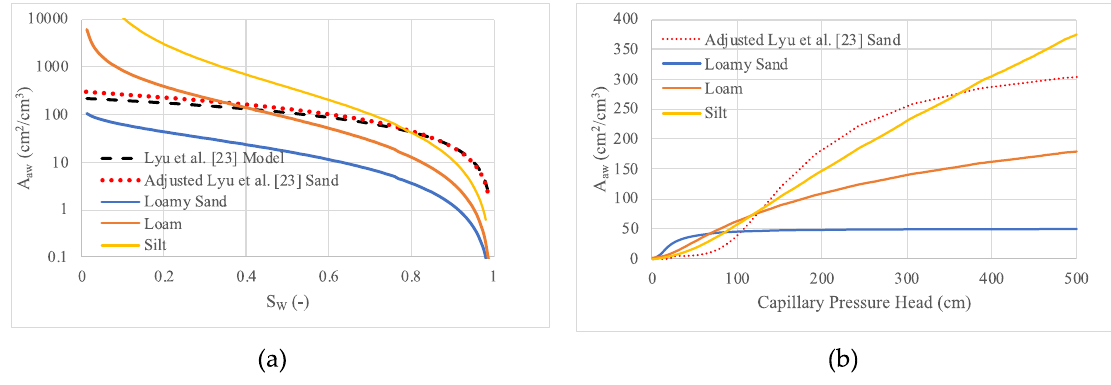
Figure 1. ( a ) 𝐴 (cid:3028)(cid:3050) (cid:4666)𝑆 (cid:3050) (cid:4667) and ( b ) 𝐴 (cid:3028)(cid:3050) (cid:4666)ℎ (cid:3030) (cid:4667) functions for media categories used in this work.